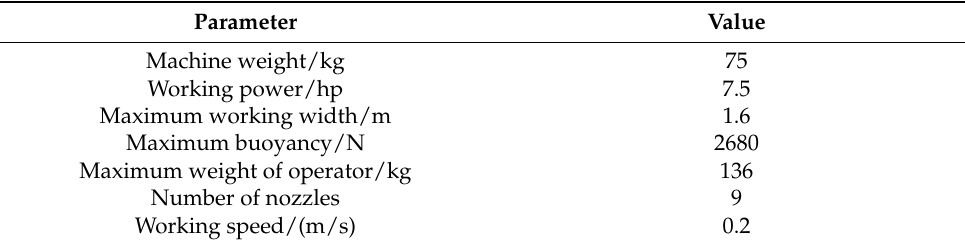
Figure 1. The lotus root digging machine: (1) driving component, (2) frame, (3) gasoline engine pump set, (4) hydraulic flushing device, (5) pipelines, (6) reservoir. Table 3. Technical parameters of the lotus root digging machine. Table 3. Technical parameters of the lotus root digging machine.